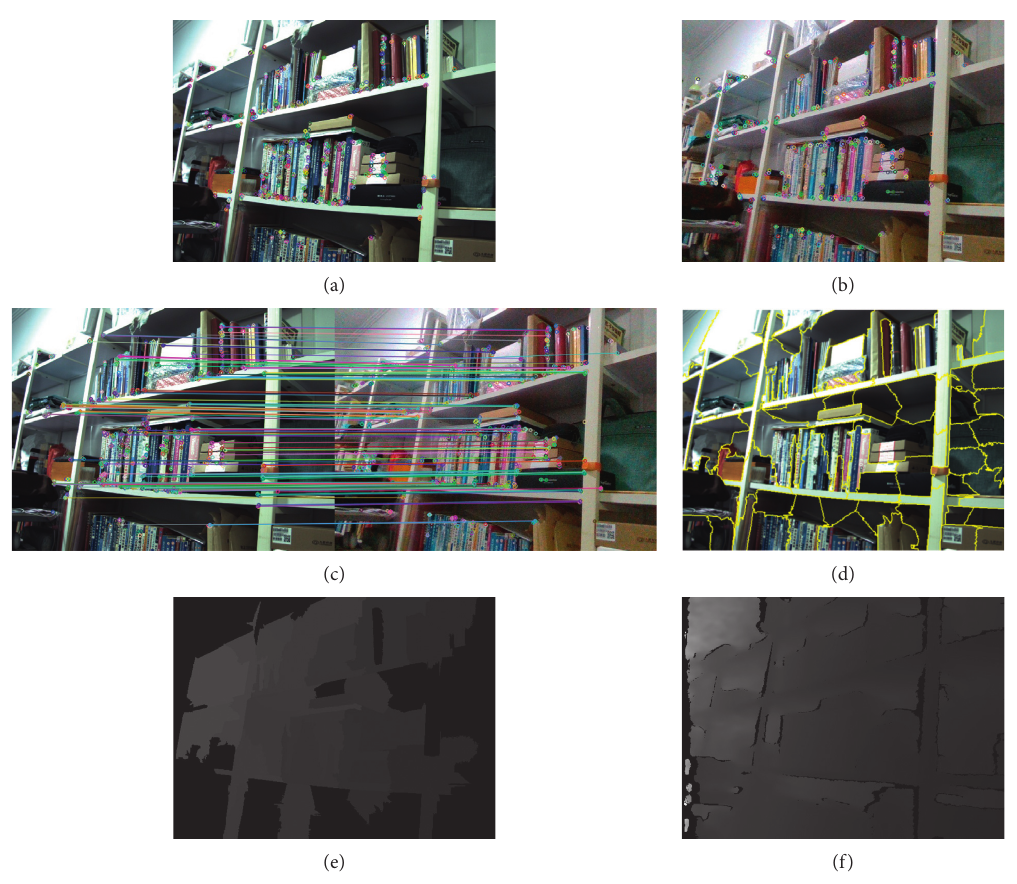
Figure 5: Algorithm test results. (a) The feature point detection result for I feature point matching result. (d) Superpixel segmentation results. (e) The depth map generated by the algorithm in this paper. (f) Depth map taken by depth